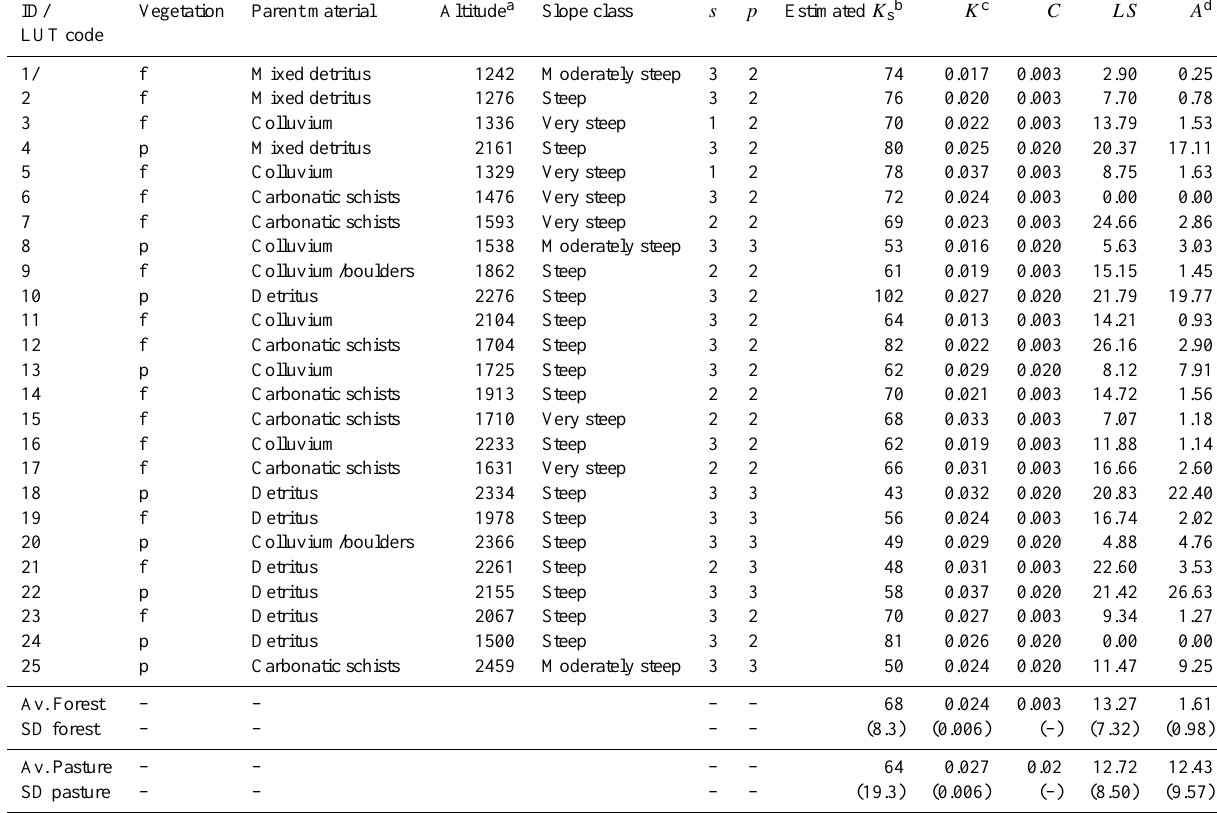
Table 2. Site characteristics and RUSLE input data at sampling points (slope sections used for RUSLE estimate). Vegetation, parent material, and average slope class refers to the land unit type. LS,C, and K refer to sampling points.